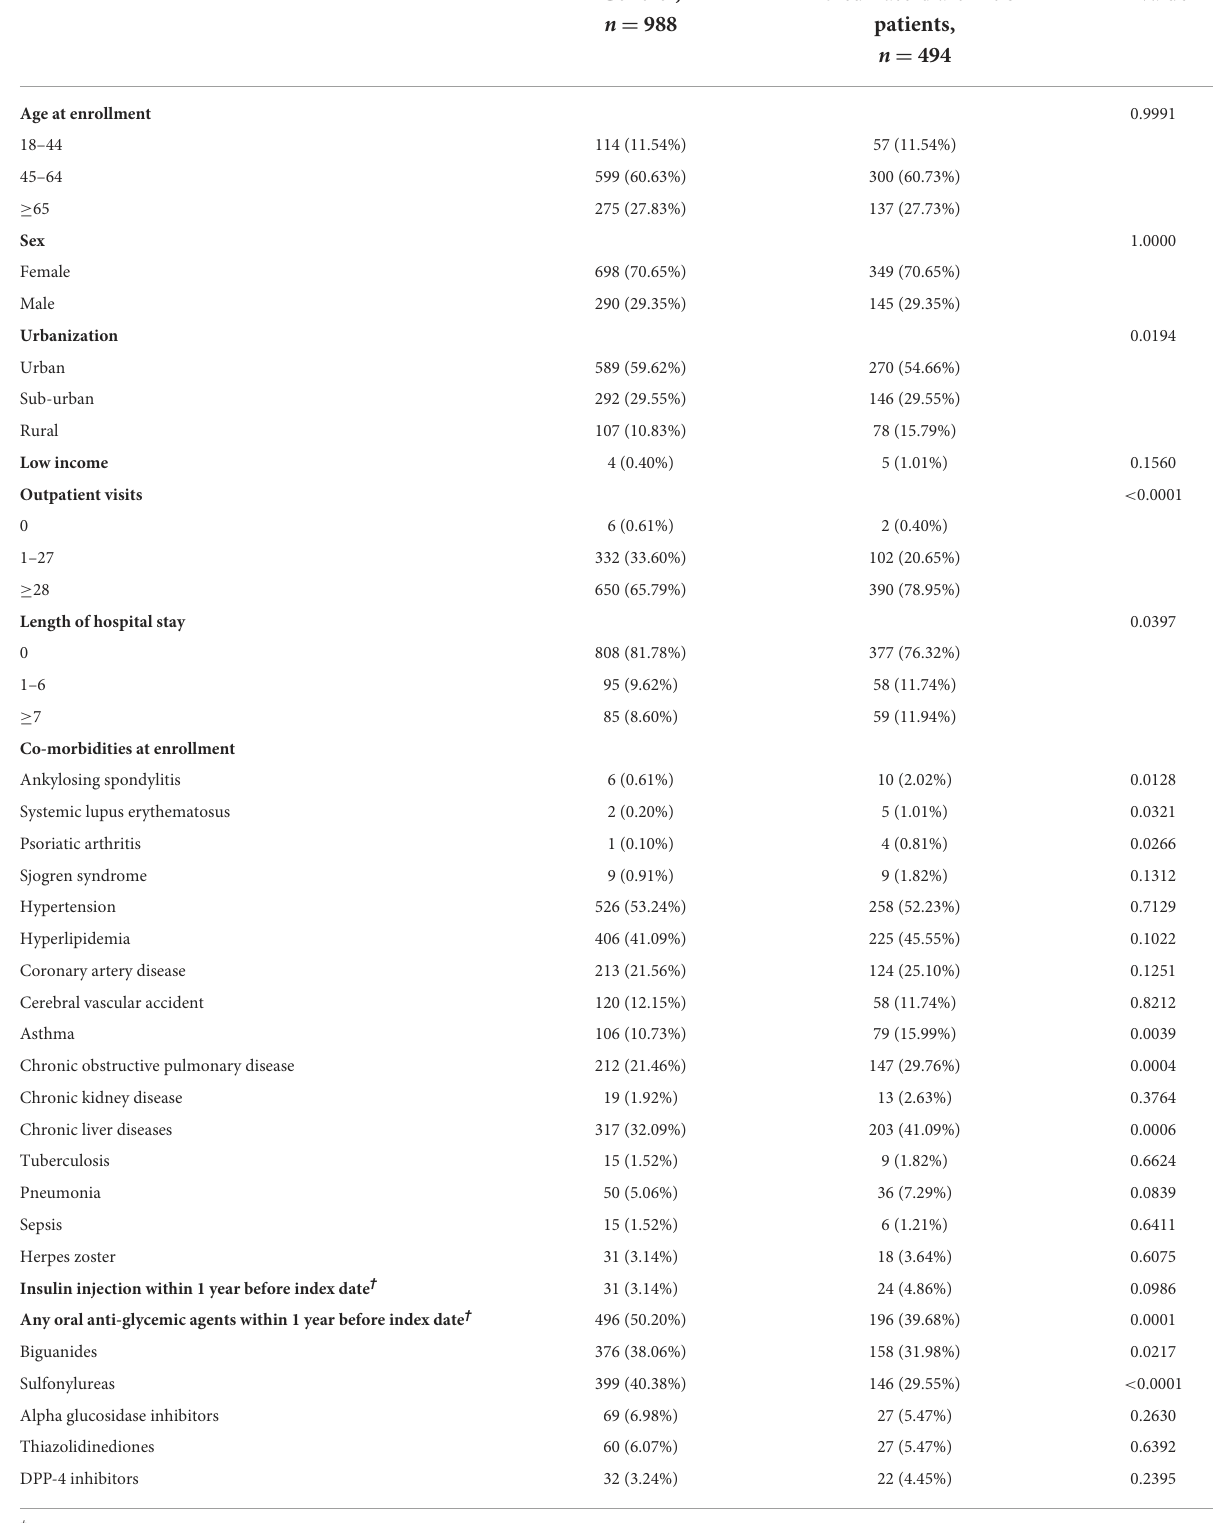
TABLE 4 Characteristics of diabetes patients with or without rheumatoid arthritis among nested case-control